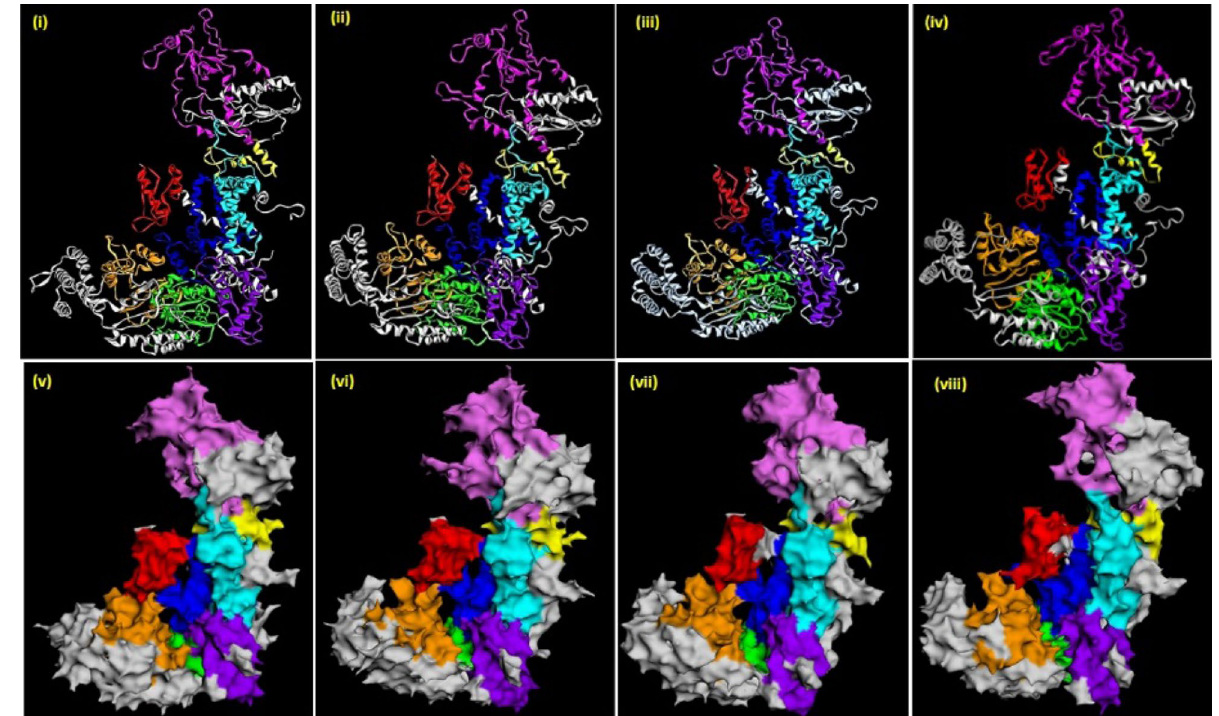
Figure 3. Predicted tertiary structure of MiDCR-1.1 of M. incognita (i, v), representative of the eight Meloidogyne spp., and those of C. elegans, (ii, vi), H. sapiens (iii, vii) and A. thaliana (iv, viii). The structures were predicted from translated nucleotide sequences of DCRs in the respective genomes using Phyre2 and re-created by EzMol to show the backbone structures and globular protein structures. Designation of domains/motif: Helicase ATP - helicase ATP binding domain, Helicase C terminal - helicase C terminal domain, Dicer Dimer - dicer dimerisation domain, PAZ PAZ domain, RNase IIIa - RNase IIIa domain, RNase IIIb - RNase IIIb domain, DSRM - double-stranded RNA binding motif.